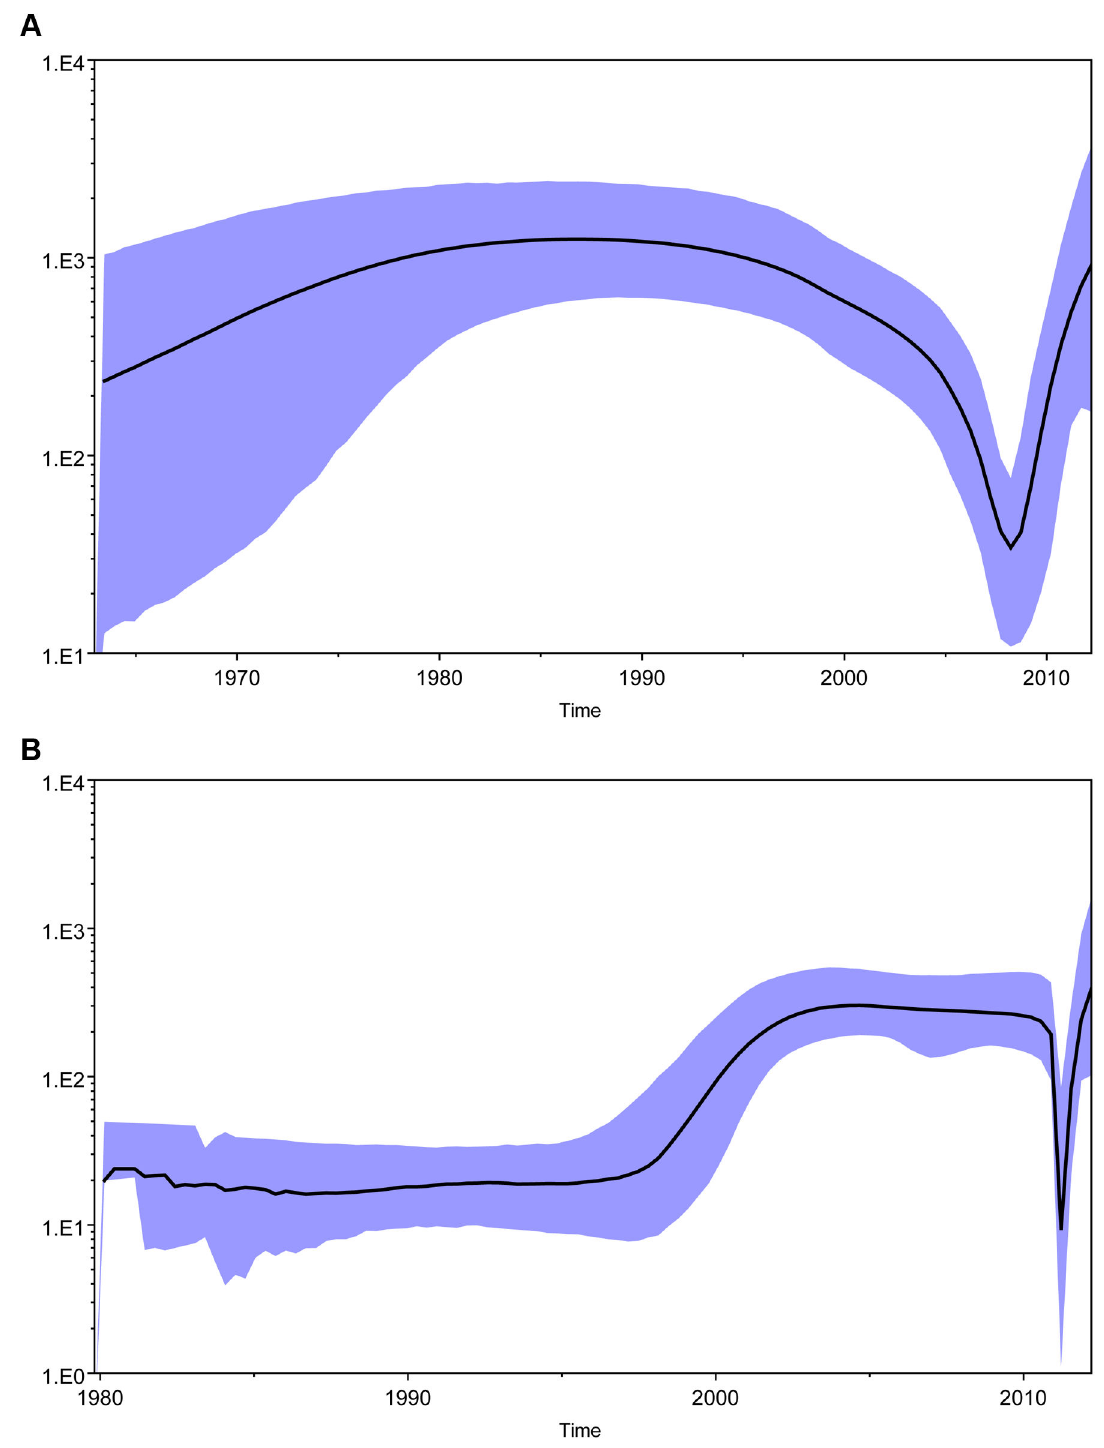
Figure 6. The reconstructed Bayesian skyline plot of the history of Heyuan HCV 2a and 6a clusters. Bayesian skyline plot was reconstructed to estimate the effective infection numbers of Heyuan 2a cluster (A) and 6a cluster (B). X-axis is the year of the infection, Y-axis indicates the estimated HCV infection population size. Black line represents the estimated effective population size through time. The blue area represents the 95% upper and lower highest posterior density (HPD) confidence intervals for this estimate. doi: 10.1371/journal.pone.0082304.g006 PLOS ONE |